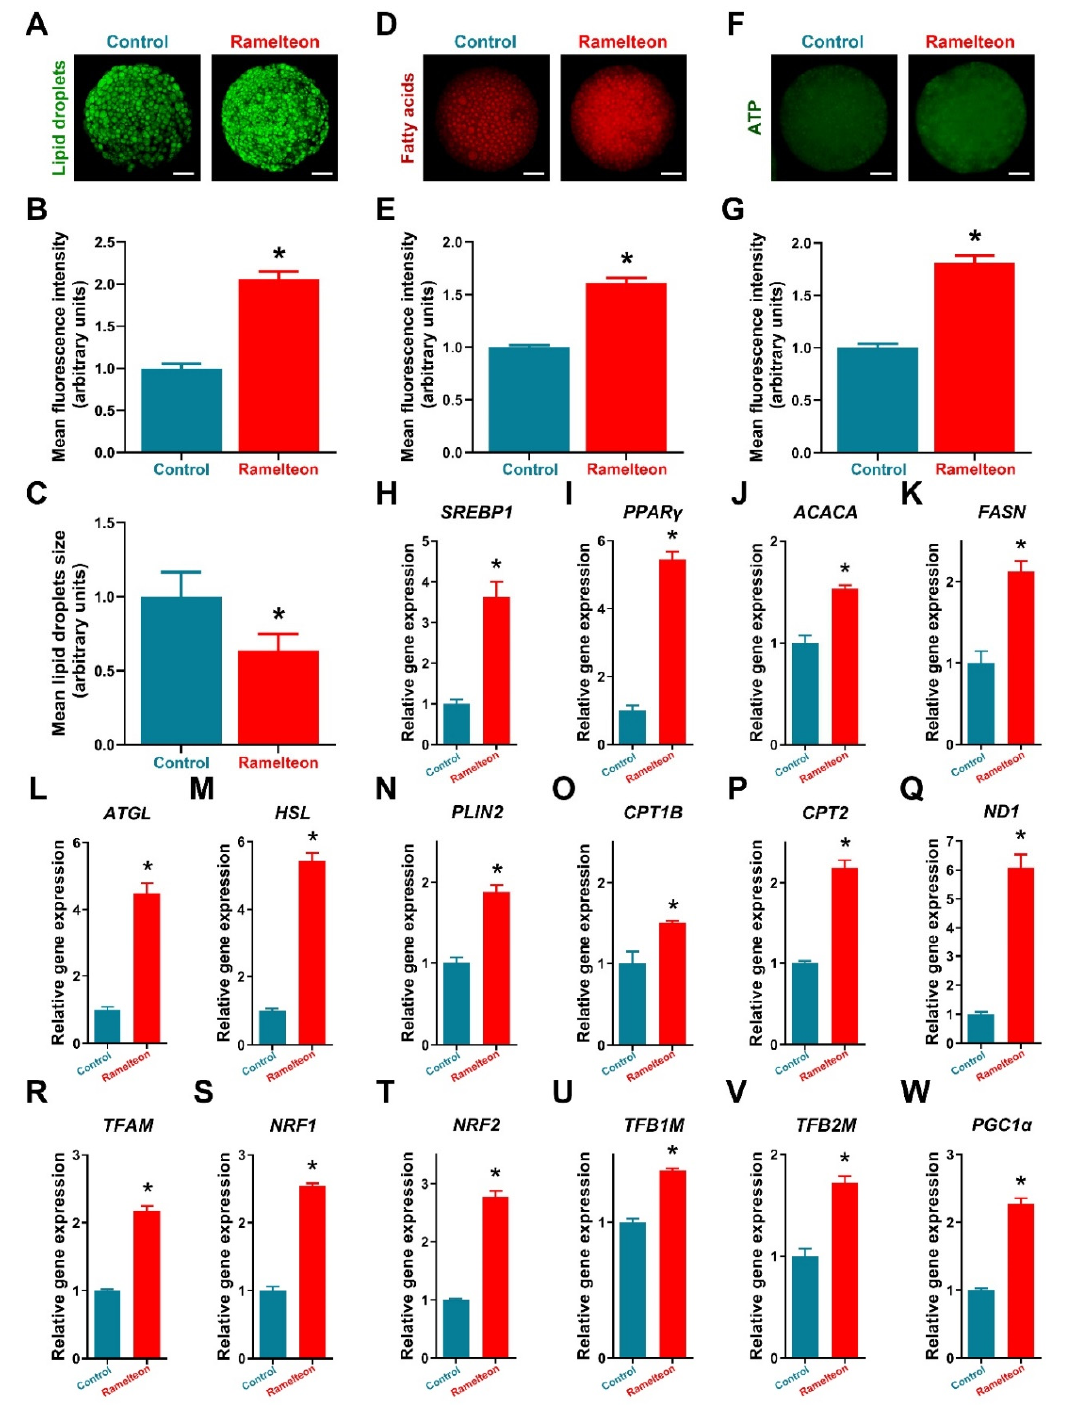
Figure 4. Detection of lipid metabolism − related indicators in porcine oocytes. ( A – C ) Lipid droplets intensity and size; ( D , E ) Fatty acid contents; ( F , G ) ATP contents; ( H – W ) Lipid metabolic gene expression. Within the same indicator, bars with an asterisk are significantly different ( p < 0.05). Results are shown as the average ± SEM of at least three repeats of independent experiments. Ramelteon concentration is 10 − 11 M. Scale bars = 30 µ